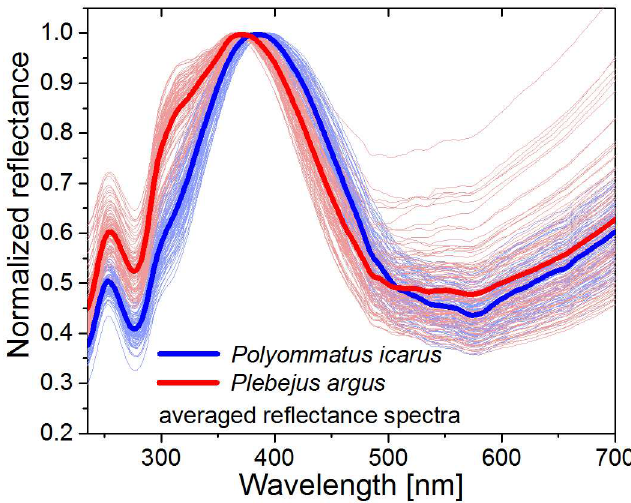
Fig 2. Species-specific normalized reflectance spectra(measuredby integrating sphere) of Polyommatus icarus and Plebejus argus . Spectra averaged over 100 wing samplesfor each species are shown in bold lines, the normalized raw spectra of the wings (n = 100 each species) are plot in the background. Note the wavelengthdifference of the main reflectancepeak and the shoulderof P . argus at approximately 320